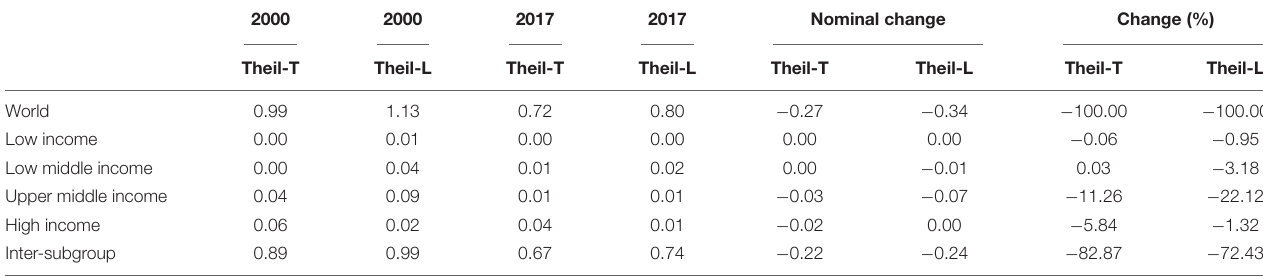
FIGURE 5 | Decomposition of inequality for different income subgroups, 2000–2017. Source: Authors’ calculation. TABLE 8 | Decomposition of change in inequality for different income subgroups,